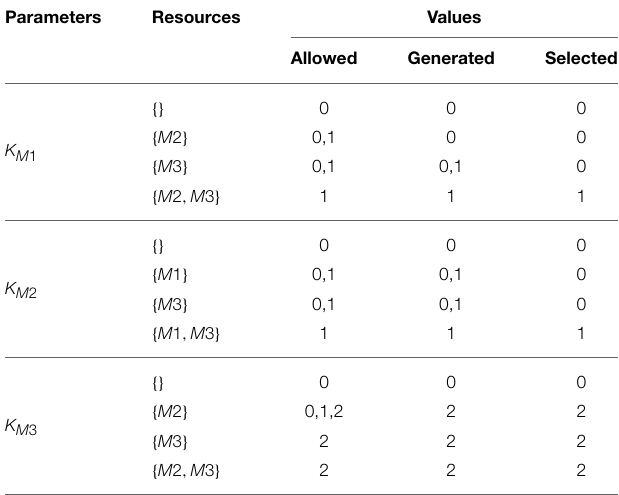
TABLE 1 | Case Study 1: Parameter table.